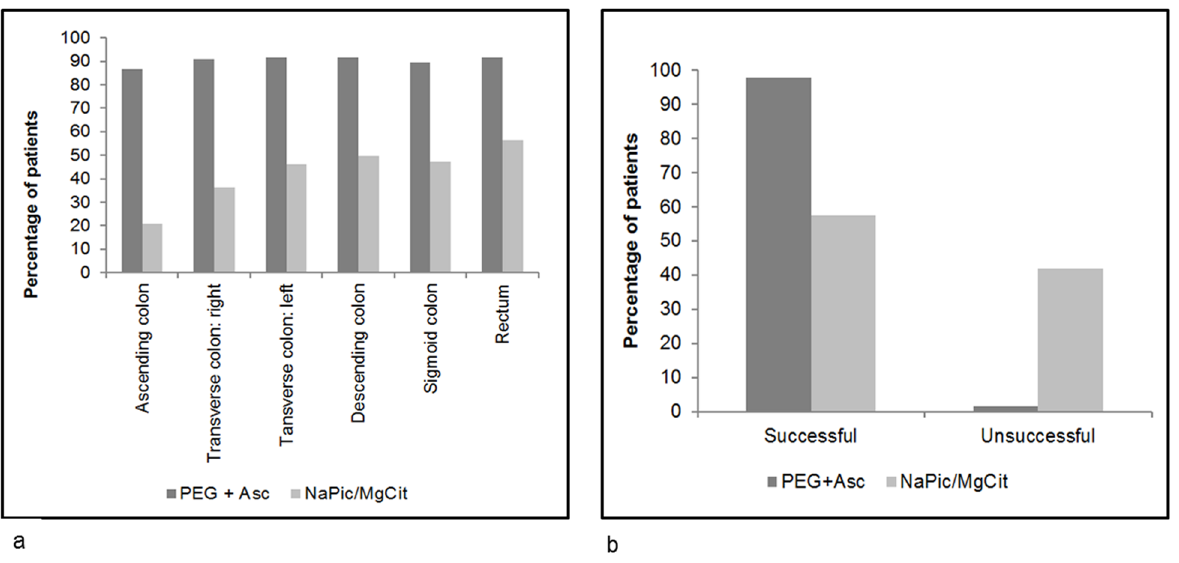
Fig 4. Assessments of cleansing using the Harefield Cleansing Scale [20] (ITT population). (a) The percentage of patients with Grade 4 (Very good) or Grade 3 (Good) cleansing quality in various areas of the colon. Results are presented for those patients who received PEG+Asc and NaPic/MgCit bowel preparations. NaPic/MgCit, sodium picosulfate/magnesium citrate; PEG+Asc, polyethylene glycol plus ascorbate. (b) Overall colon cleansing success of PEG+Asc compared to NaPic/MgCit assessed during withdrawal of the colonoscope.